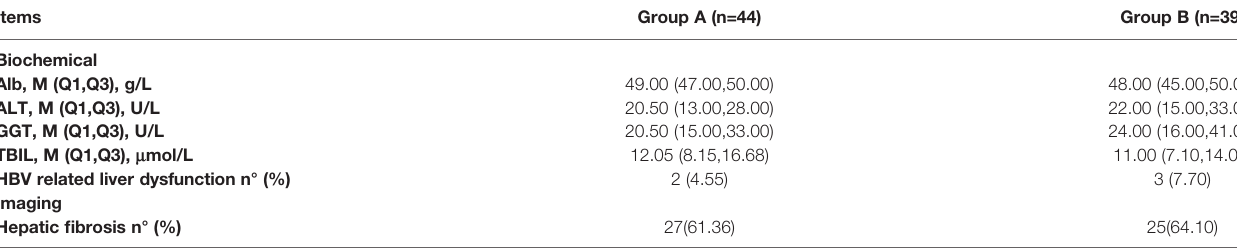
TABLE 2 | Results of biochemical and imaging examination in OBI patients at week